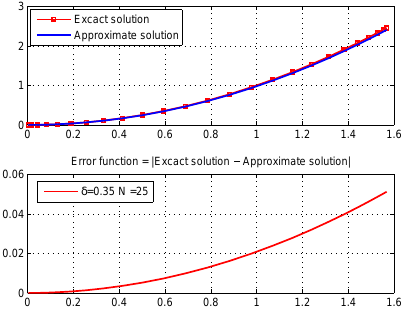
Figure 1. Example 1: exact and computed approximate solutions, absolute errors with n = 25 and noise level